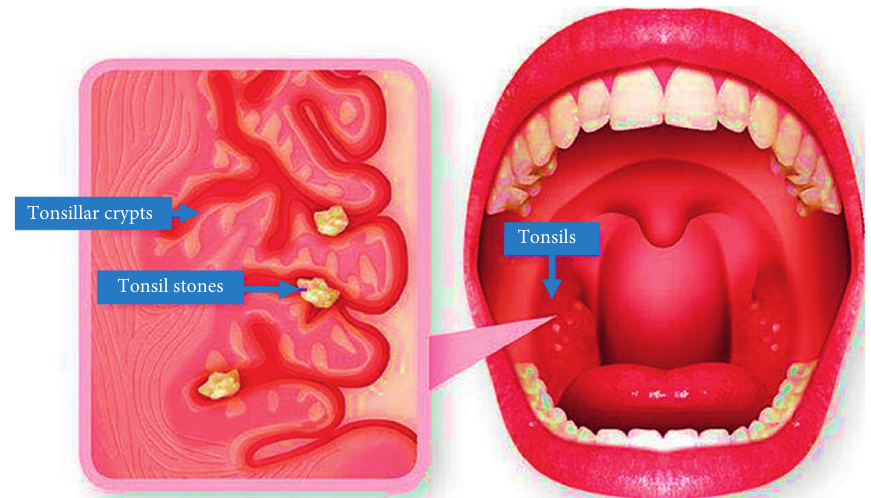
Figure 2: Location of the tonsil in the oral